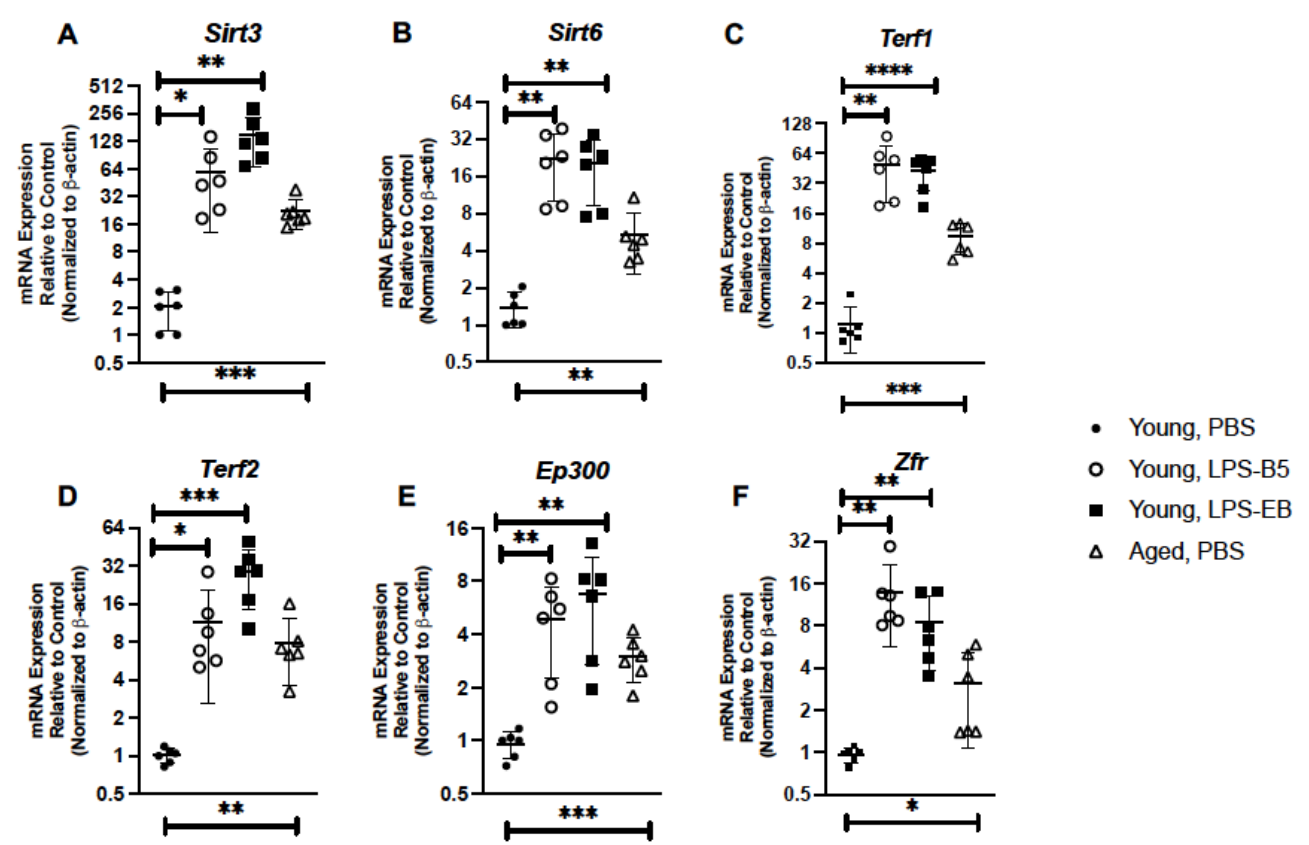
Figure 8. Treatment of Young Mice with Low-Dose LPS Alters Senescence Modulatory Genes in Lung. Lung tissue was collected from PBS-, LPS-B5-, and LPS-EB-treated young adult BALB/c mice (3 months of age). Expressions of ( A ) Sirt3 , ( B ) Sirt6 , ( C ) Terf1 , ( D ) Terf2 , ( E ) Ep300 , and ( F ) Zfr were assessed by real-time PCR. Aged (20 months) PBS-treated lung expression analysis is included for comparison. N = 6 mice per group, and the experiment was repeated 3 times. * p < 0.05, ** p < 0.01, *** p < 0.001, and **** p < 0.0001.